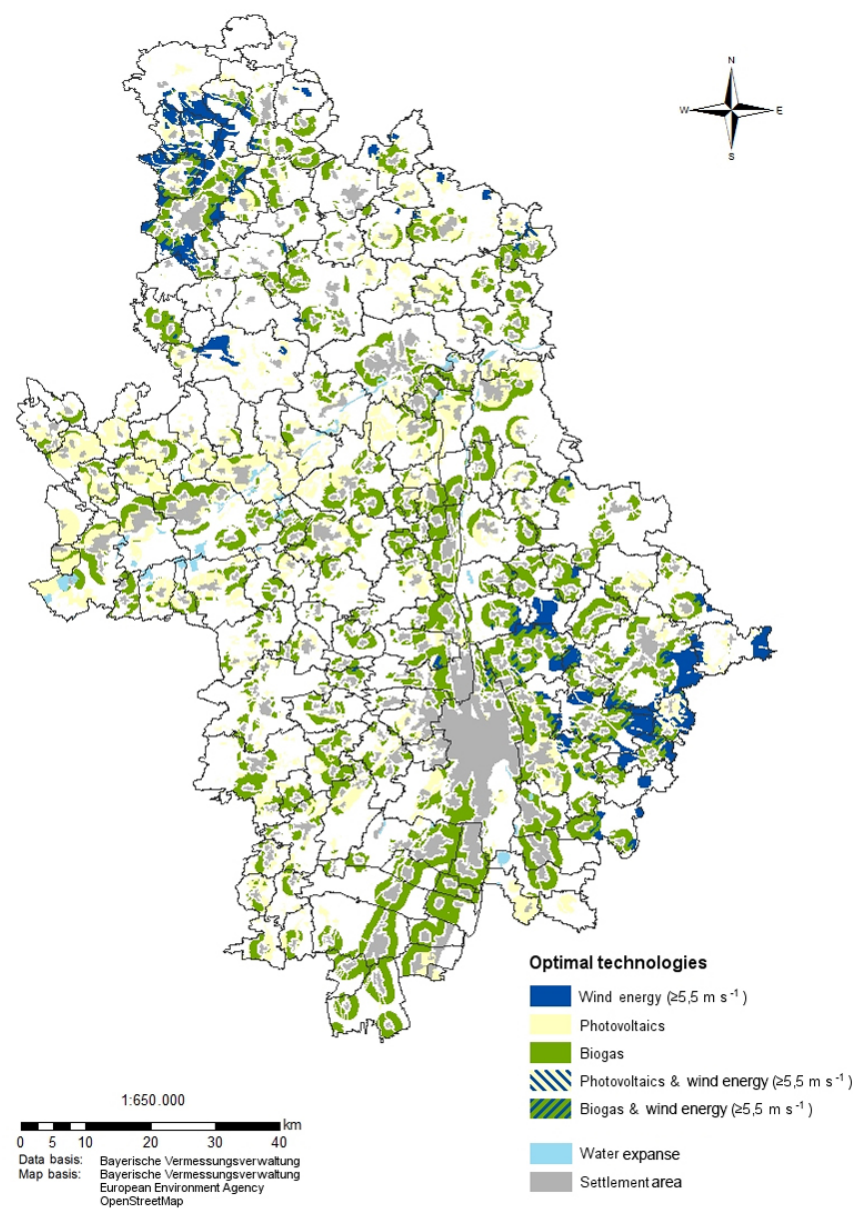
Figure 3. Spatially compatible assignment of technologies including optimal natural site factors – current technological